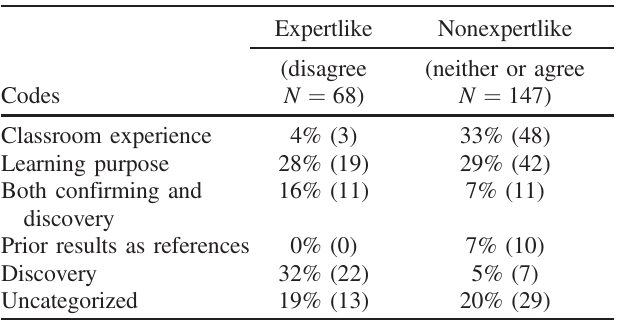
TABLE III. Student views about Q1a “ The primary purpose of doing physics experiments is to confirm previously known results. ” The percent of students with expertlike or nonexpertlike Likert-scale selections whose reasoning contained particular codes. Students ’ reasoning may be coded under several codes when appropriate so percents in each column may not add up to 100%. N is the total number of students with expertlike or nonexpertlike views and the number of students with each code is given in parentheses. Codes with total frequency less than 10 (around 5% of the total population) are not shown.